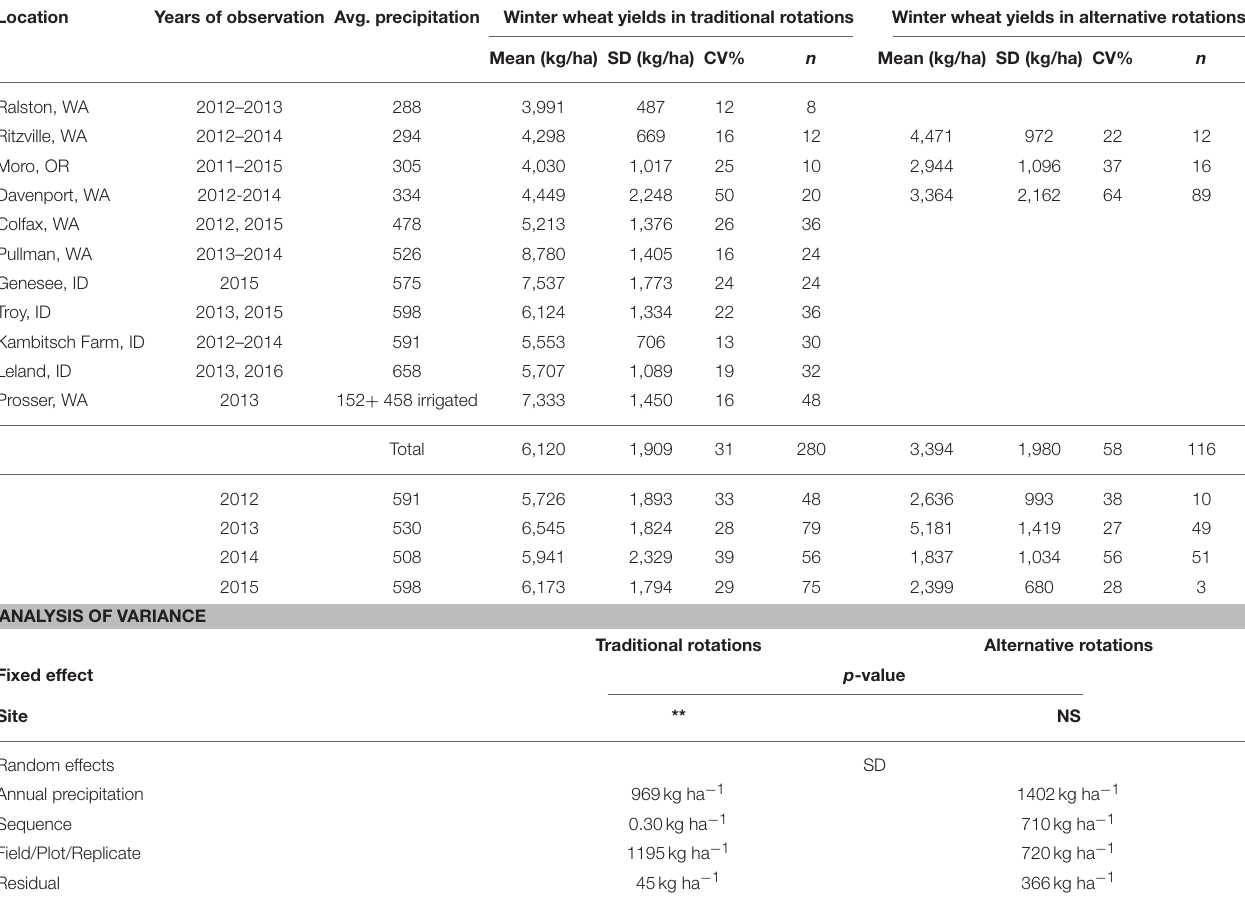
TABLE 2 | Mean and variance of winter wheat produced at 11 site locations in the inland Pacific Northwest region. Location Years of observation Avg. precipitation Winter wheat yields in traditional